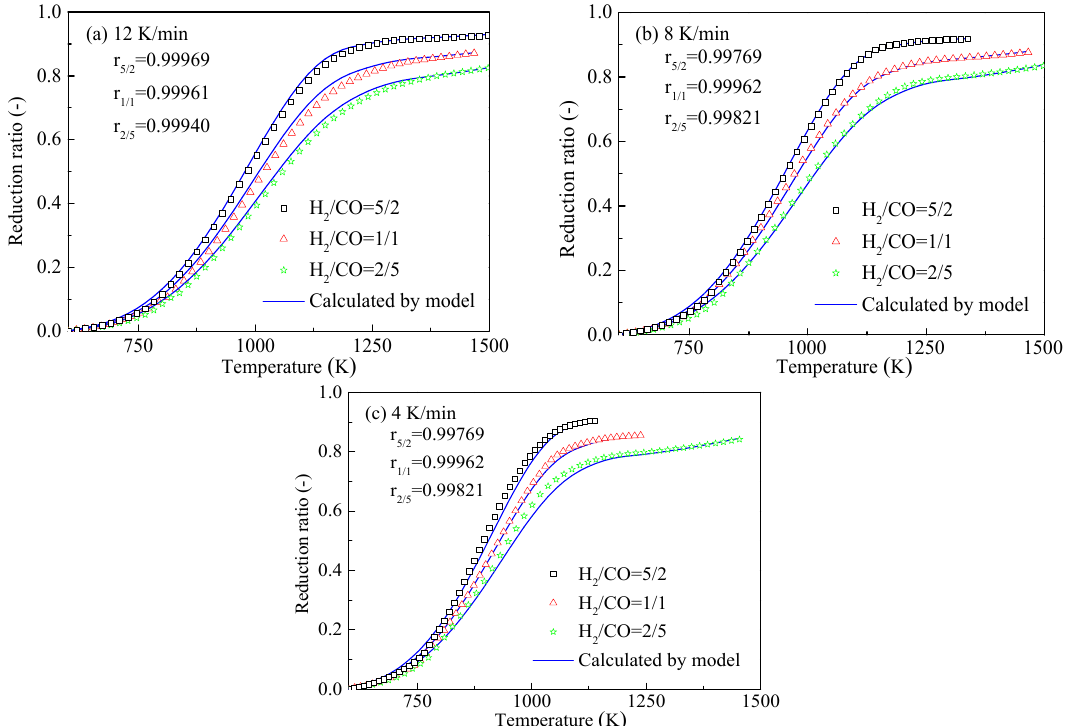
Figure 17. Comparison between the experimental and calculated non-isothermal reduction ratio with different gas compositions ( a ) 12 K/min; ( b ) 8 K/min; ( c ) 4 K/min.